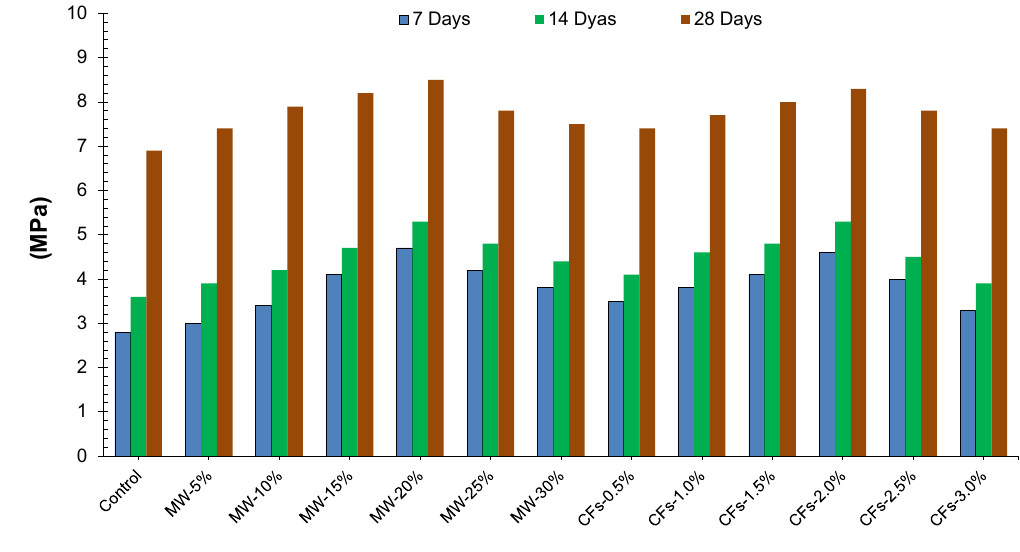
Figure 12. Split tensile